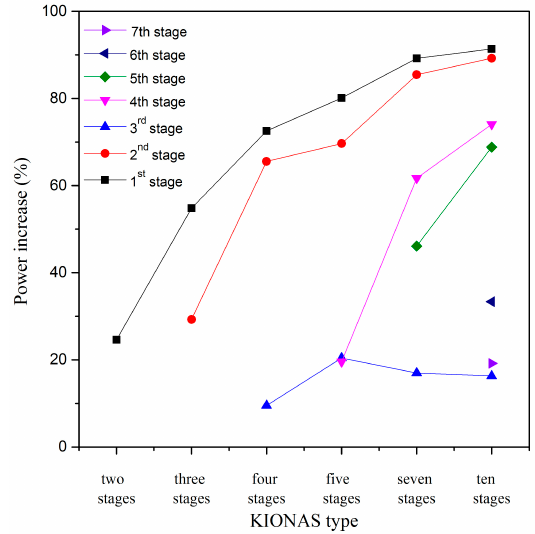
Figure 10. Each stage’s increase in power by adding additional stages.